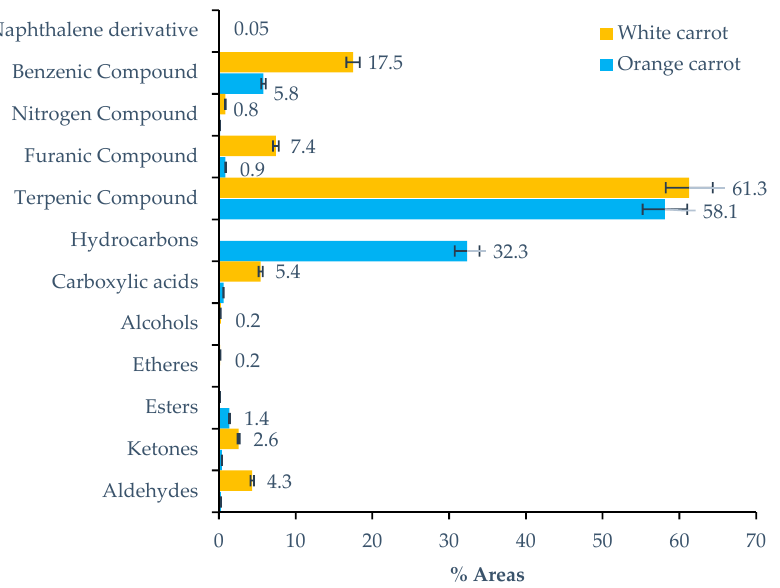
Figure 1. Distribution of chemical families identified in orange and white carrot.